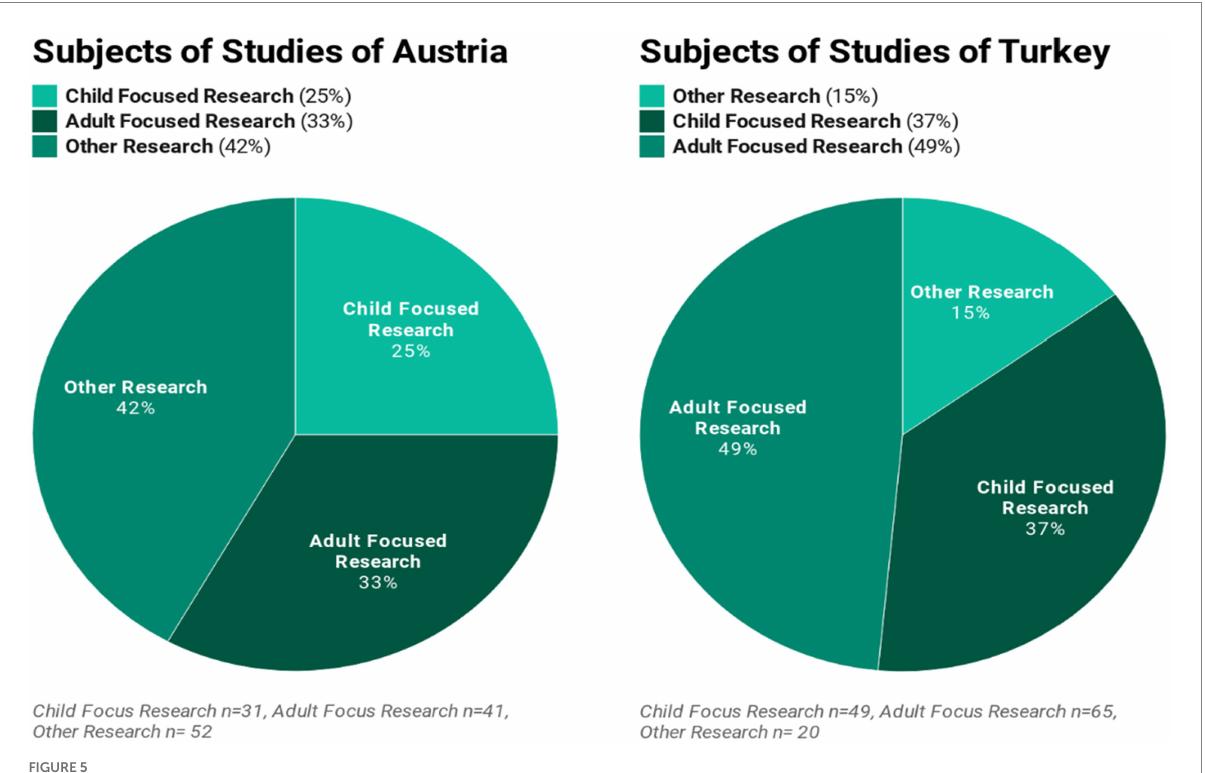
FIGURE 5 Distribution of research topics by